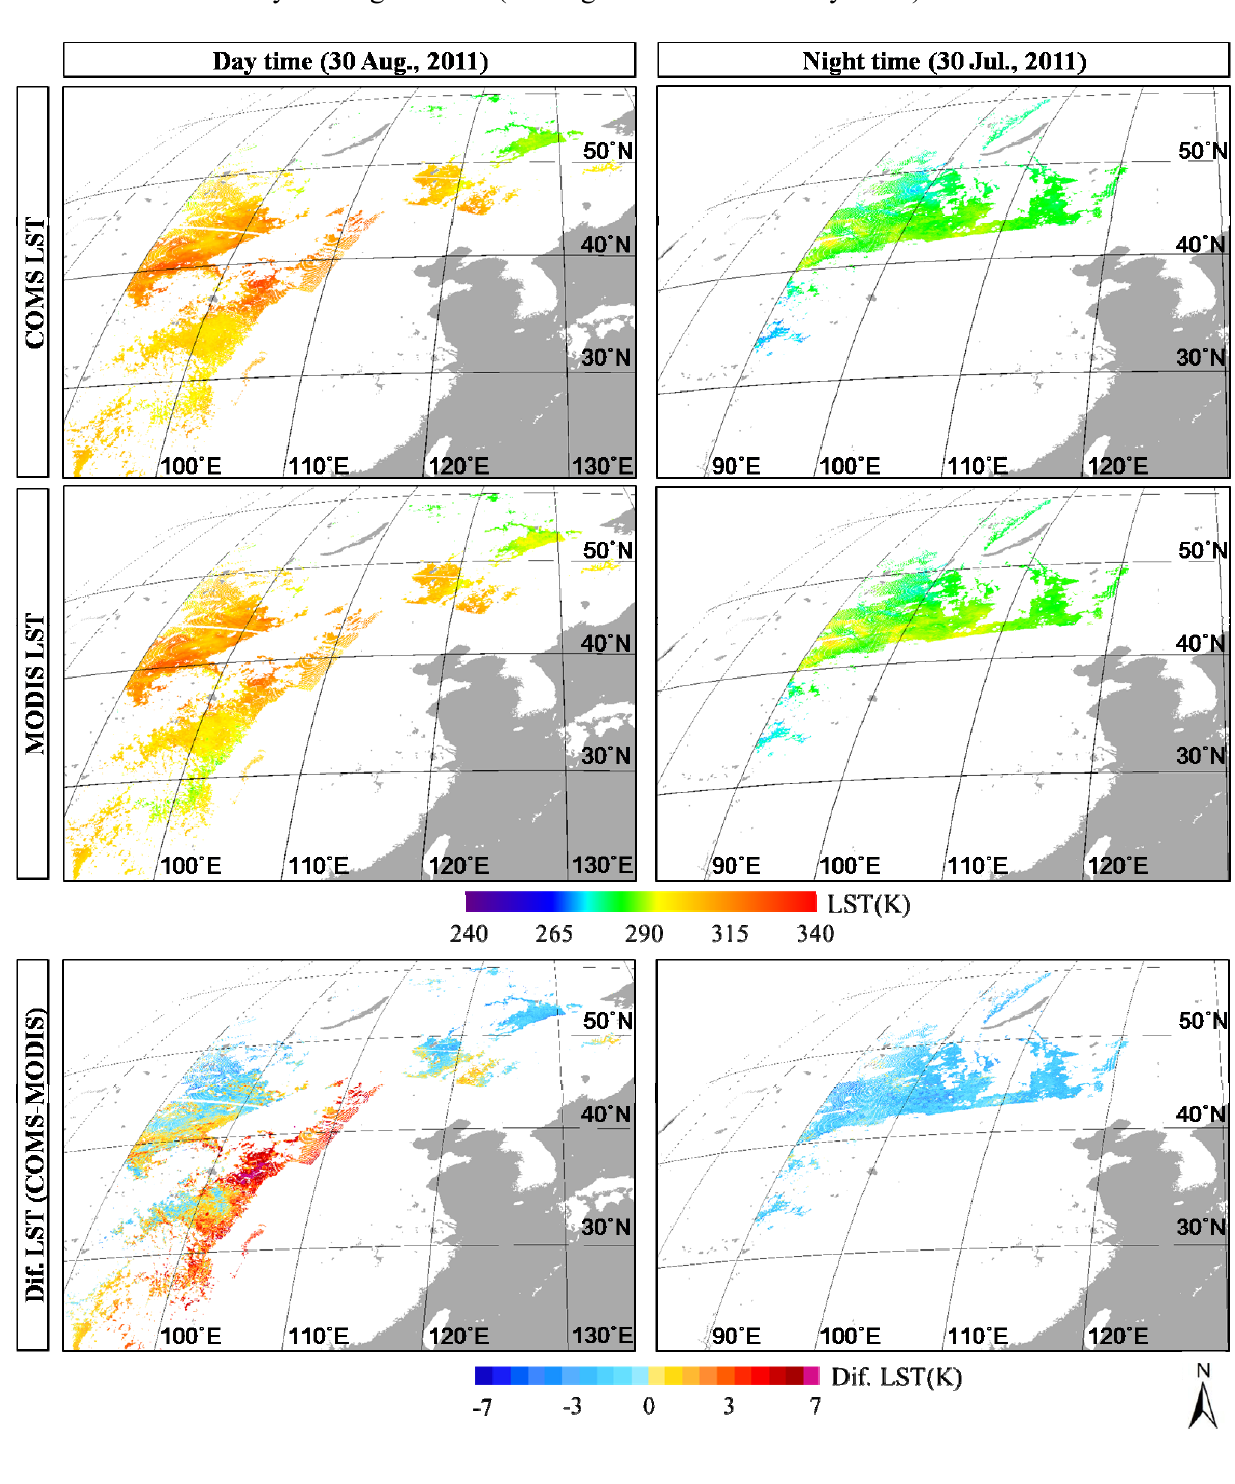
Figure 8. Spatial distribution of COMS LST and MODIS LST data and their differences for two select days during summer (30 August 2011 and 30 July